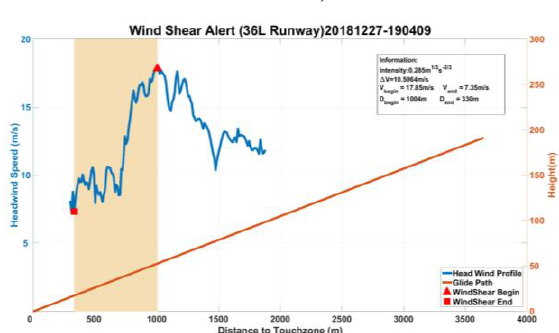
Fig.6. Glide path radial velocity of 36L runway on December 27, 2018.